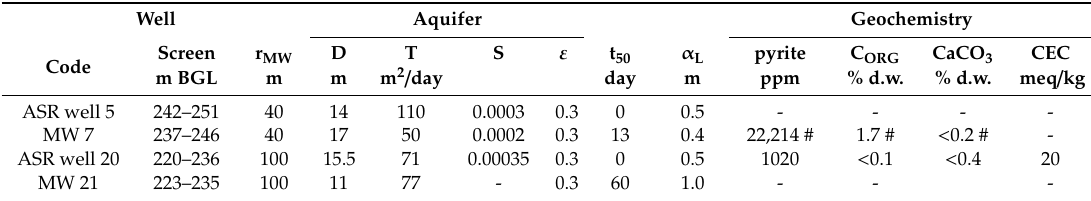
Table 2. Characteristics of principal wells in both ASR pilots, and of local aquifer. r MW = radial distance ASR to monitoring well; D = thickness, T = transmissivity, S = storativity, ε = e ff ective porosity, t 50 = travel time, α L = longitudinal dispersivity.